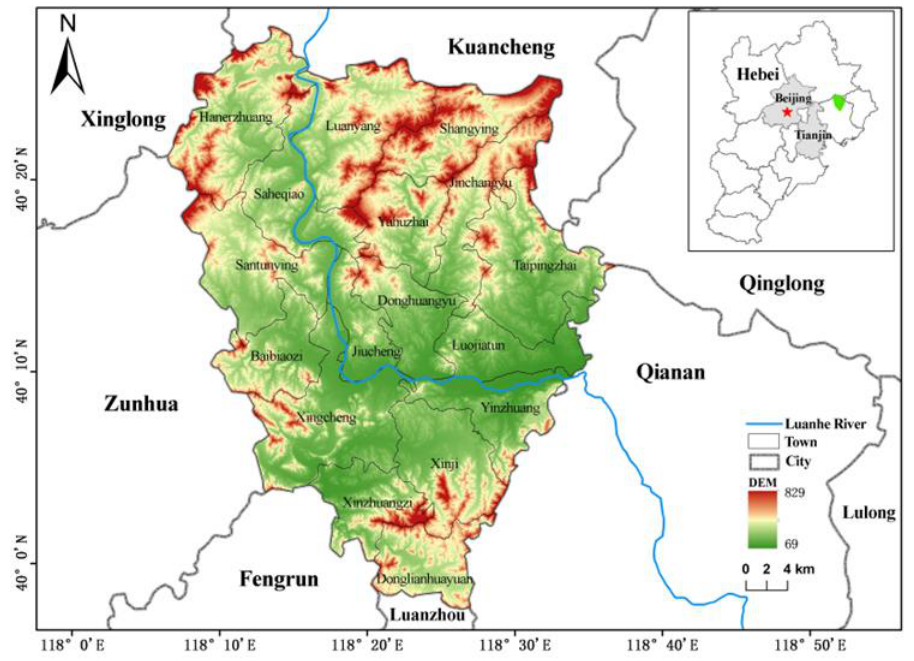
Figure 2. Location of the study area.